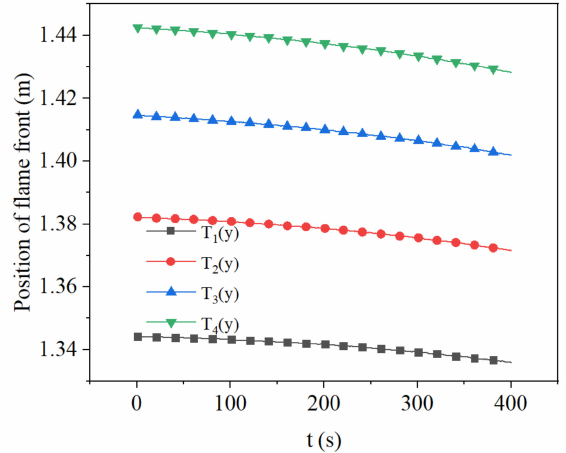
Figure 23. Change of flame front position with time at different initial temperature peaks with the inlet flow rate of 700 m 3 /h, X CH = 4